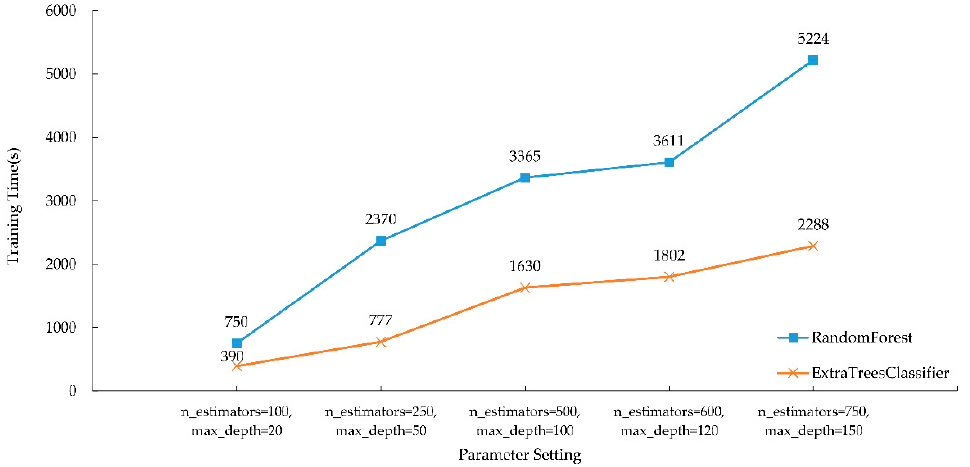
Figure 10. The training time of estimators with different size. Table 10. Final configuration of multi-grained